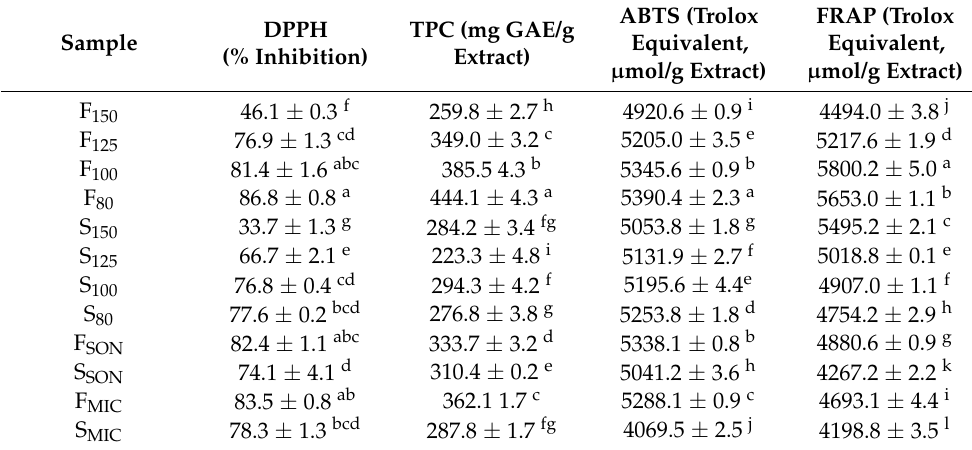
Table 5. Antioxidant potential of pecan shell extracts *.